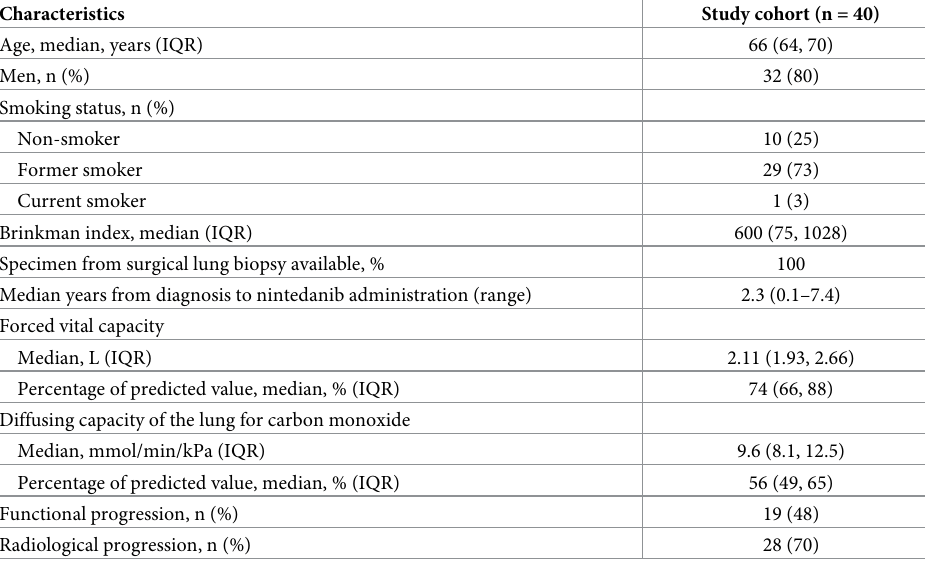
Table 1. Patients